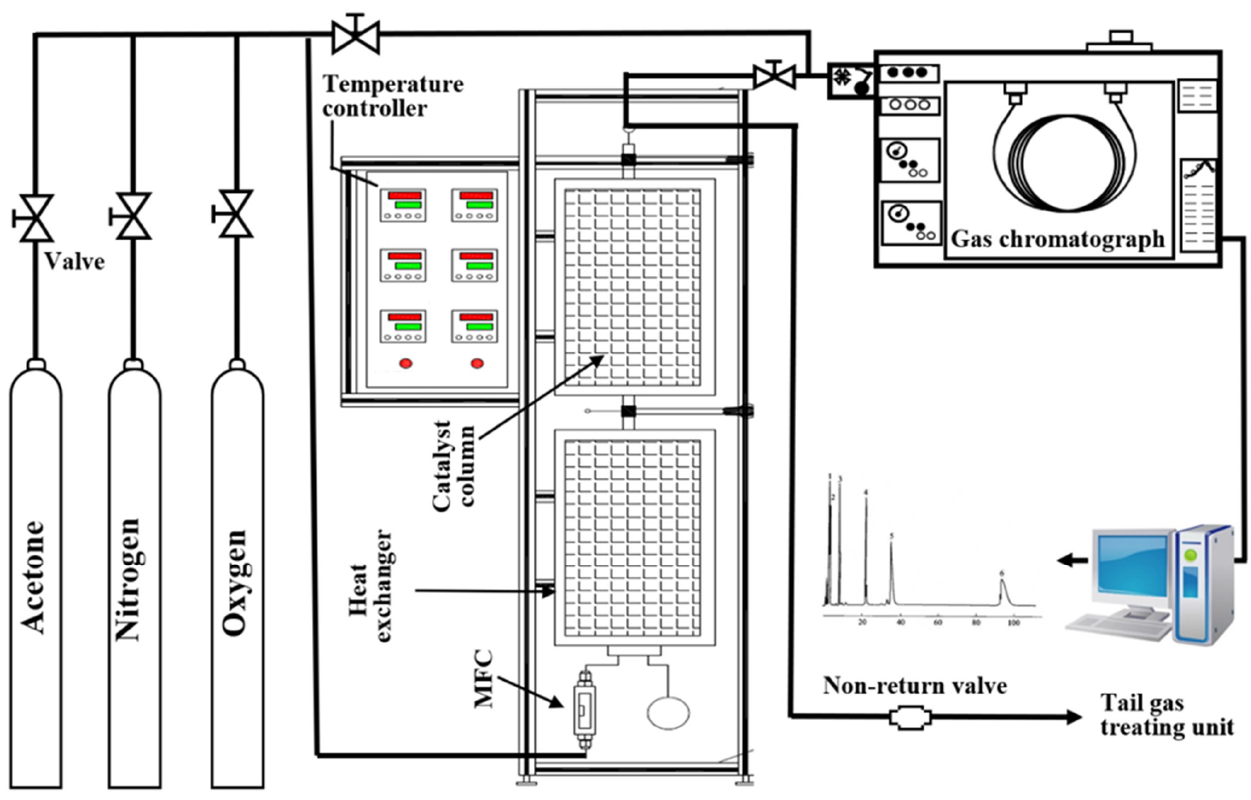
Figure 1. Configuration of the experimental apparatus.